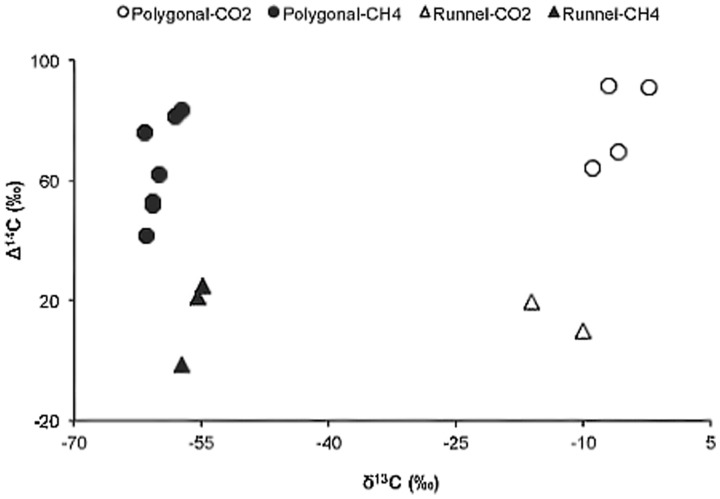
CH4 and CO2 carbon source and age.Radiocarbon signature (Δ14C) plotted against δ13CH4 and δ13CO2 showing: 1) that as the fraction of young carbon becomes higher for both CH4 and CO2, the δ13C signatures become more divergent indicating a decoupling in carbon source; 2) the runnel ponds CH4 contains a higher fraction of old carbon.